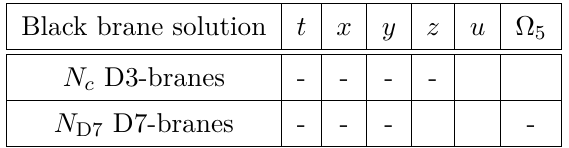
Table 1 . The configuration of the D-branes in the black brane solution. “-” represents the D-brane extends along the